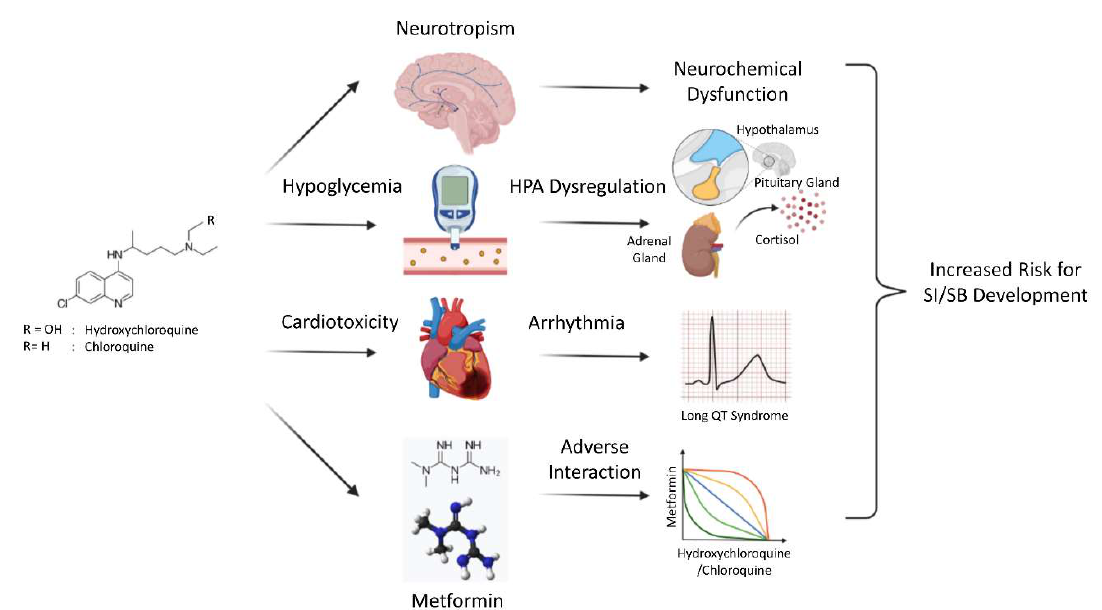
Figure 1. Putative mechanisms of HCQ/CQ-induced neuropsychiatric adverse events. Biochemical properties of HCQ/CQ can cause several side effects that might contribute to the development of SI/SB. Its accumulation in the brain can cause disruption of neurotransmitter signaling circuits involved in the pathogenesis of suicide. Its metabolic and cardiovascular impacts can result in abnormal cortisol release and arrythmia, both of which have been linked to increased suicide risk. The adverse interaction of HCQ/CQ with metformin might also precipitate in fatal neuropsychiatric outcomes. Legend: SI = suicidal ideation; SB = suicidal behavior; HPA = hypothalamic-pituitary-adrenal axis.